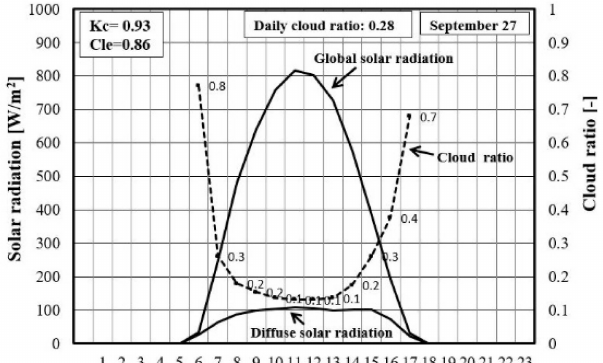
Figure 6. Daily cloud ratios, Kc and Cle of a relatively clear day selected from each month (from January to September) in Shanghai, China.